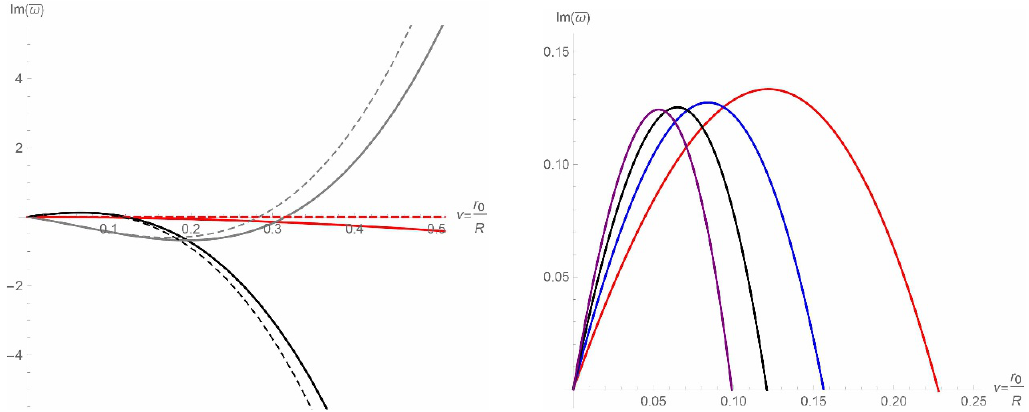
Figure 6 . The left plot exhibits the behaviour of the imaginary part of the frequencies ! 2 (red solid line), ! 3 (black solid line) and ! 4 (grey solid line) for black rings up to second order in derivatives as a function of the ring thickness (cid:23) = r 0 =R for D = 7 and m = 10. The dashed lines are the corresponding frequencies for boosted black strings in (3.12) with critical boost. The right plot exhibits the growth rate of the instability associated to ! 3 as a function of (cid:23) for m = 6 (red line), m = 8 (blue line), m = 10 (black line) and m = 12 (purple